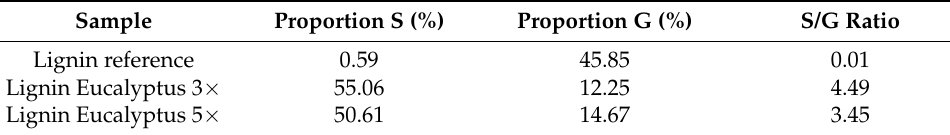
Table 3. The proportion of types of monomers in Eucalyptus lignin with